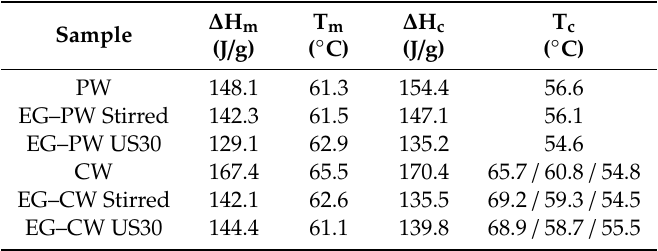
Figure 4. Dynamic di ff erential scanning calorimetry (DSC)thermograms of para ffi n wax (PW)–EG during: ( a ) heating and ( b ) cooling at 10 ◦ C / min. Table 1. Thermal properties for the PW- and CW-based